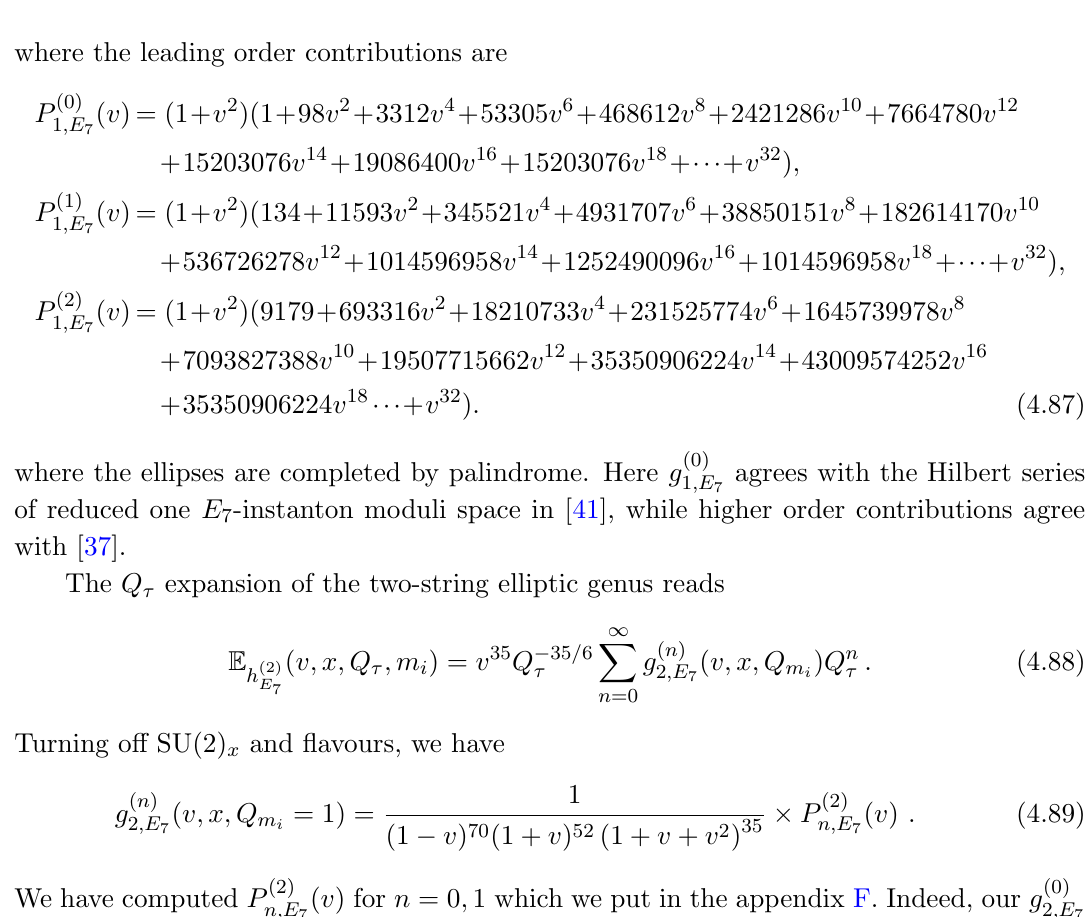
Table 10 . The r -(cid:12)elds of the n = 8 model and the fundamental weights of e 7 which induce the same embedding (cid:30) : Q _ , ! P . They can be divided into two groups; inside each group r -(cid:12)elds or fundamental weights induce the same